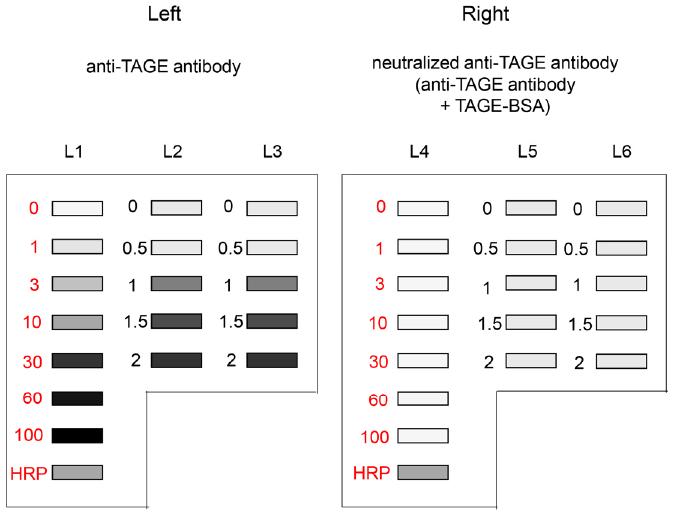
Figure 3. Chemiluminescence detection of standard TAGE-BSA aliquots, HRP marker solution, and sample solution on a PVDF membrane [27]. Both membrane sides were simultaneously exposed using Fusion FX. ( Left ) (L1–L3): Anti-TAGE antibody was probed onto the PVDF membrane. ( Right ) (L4–L6): Neutralized anti-TAGE antibody was probed onto the PVDF membrane. Closed gray and black squares indicate the bands on the PVDF membrane. L1, L4: 0, 1, 3, 10, 30, 60, and 100 ng of TAGE-BSA aliquots and HRP marker solution. L2, L3, L5, L6: cell lysate samples of C2C12 cells treated with 0, 0.5, 1, 1.5, and 2 mM glyceraldehyde for 24 h. Calibration-corrected luminance value = (HRP Left − Blank Left )/(HRP Right − Blank Right ). Di ff erence in luminance value between the one in the left side and the corrected one in the right side of the PVDF membrane (AU) = (A Left − Blank Left ) − (A Right − Blank Right ) × calibration-corrected luminance value.